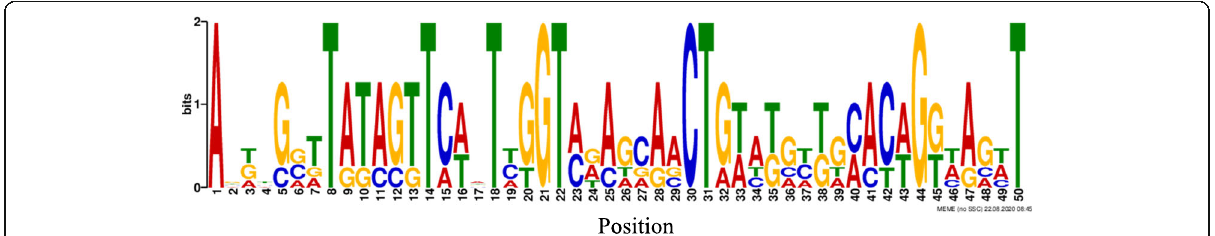
Fig. 2 Sequence logos for the identified common Mtrn I motif with different information